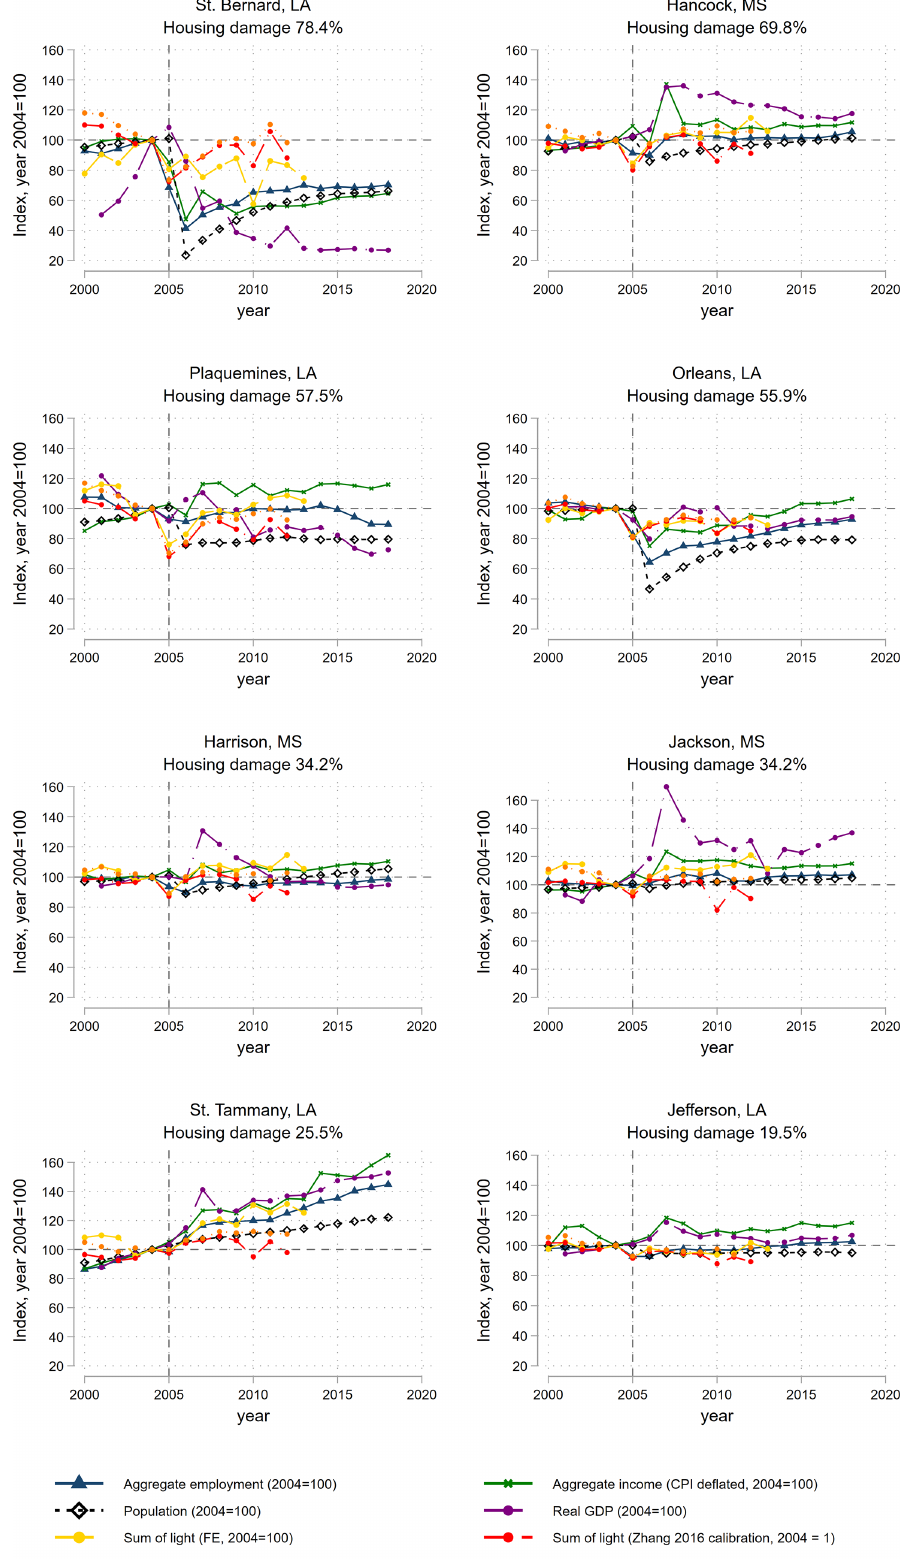
Figure A5. Night lights and economic indicators, including alternative light